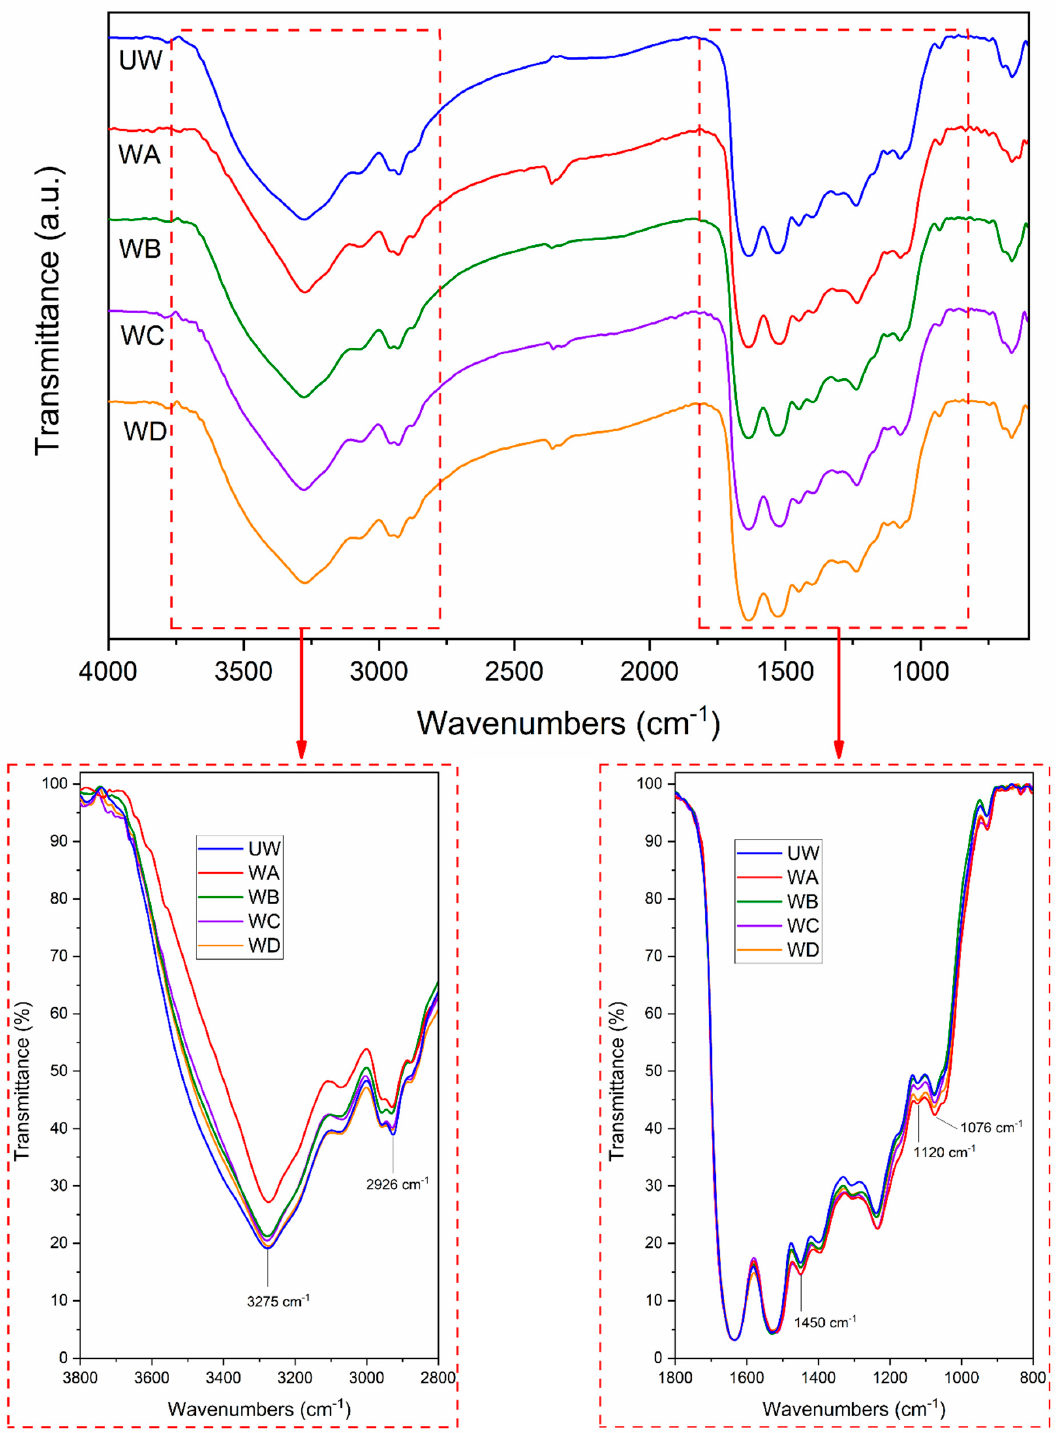
Figure 3. Fourier transform infrared (FTIR) spectra of unmodified wool (UW) and wool modified with studied coupling agents (WA, WB, WC, WD).